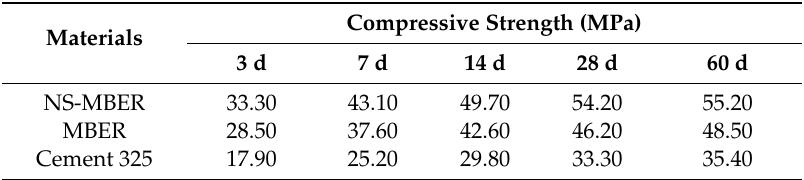
Table 4. Compressive strength of di ff erent soil stabilizer.